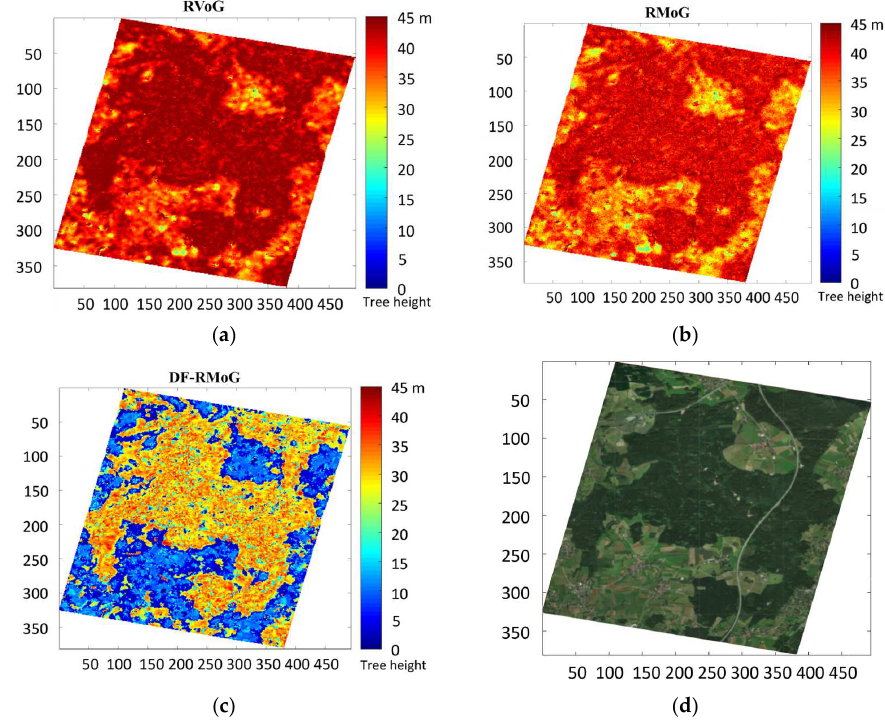
Figure 10. Forest height maps derived from different models (temporal baseline of 92 days): ( a ) RVoG. ( b ) RMoG. ( c ) DF-RMoG. ( d ) Optical image of the study site (image © 2019 Google). Similar to Section 3.3.1, the corresponding scatter plots of RVoG heights versus RMoG heights, RVoG heights versus DF-RMoG heights, and RMoG heights versus DF-RMoG heights, are generated as Figure 11a–c.